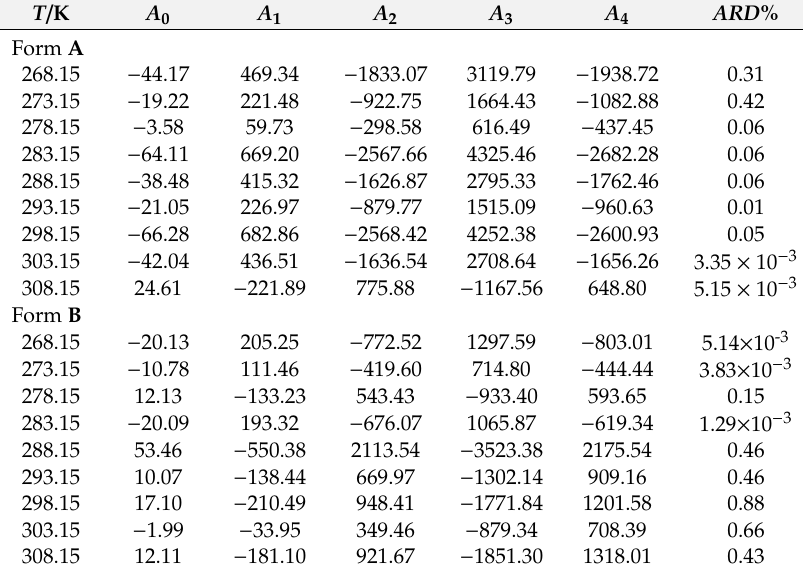
Table 4. Parameters of CNIBS / R–K model for ethyl acetate + toluene system.